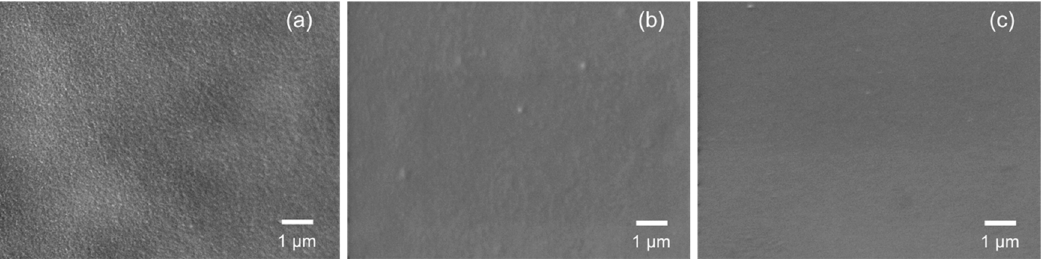
Figure 9. SEM images of the top surface view of an ( a ) as-synthesized mesoporous γ -Al 2 O 3 layer and 500 °C-synthesized membrane further modified with PCS ( b ) before and ( c ) after gas permeation measurements under p/p 0 (H 2 O) up to 1 at 50 °C.